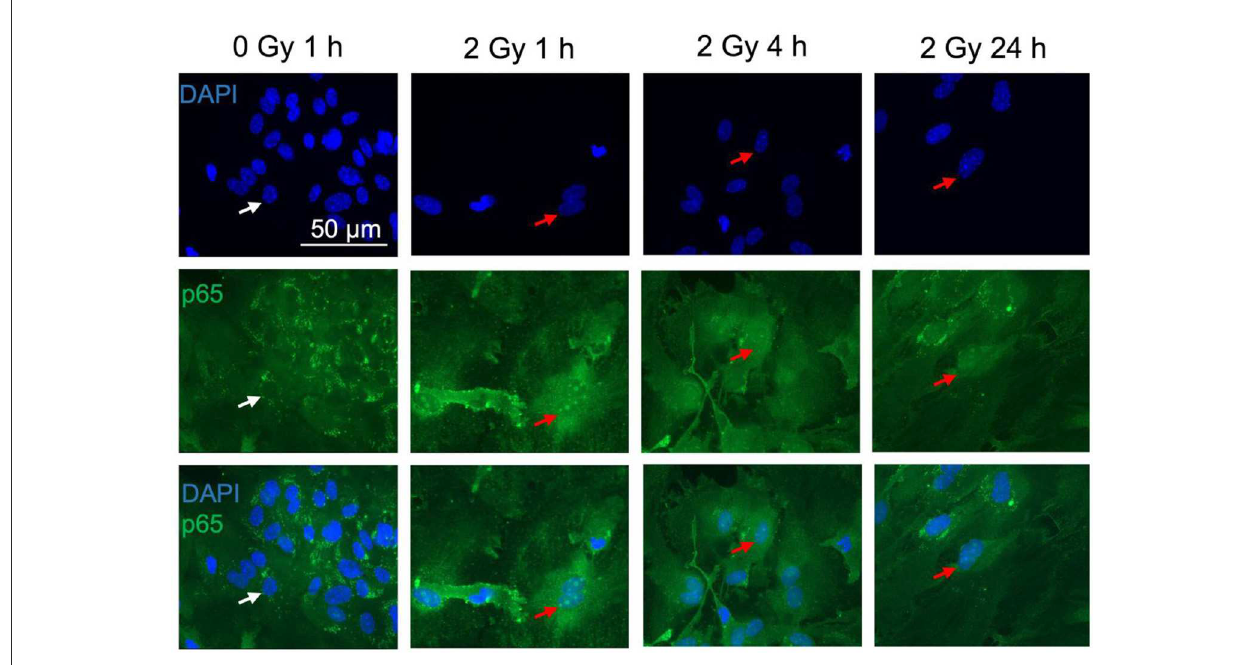
FIGURE8 The NF- κ B subunit p65 is detected in astrocytes. Astrocytes were exposed to 0Gy (mock-irradiated control) or 2Gy C ions (7 MeV/n, LET 220 keV/ µ m) and fixed 1, 4, and 24h after treatment for immunofluorescence staining of the NF- κ B subunit p65 (green). p65 is known to translocate from the cytoplasm into the nucleus upon NF- κ B pathway activation. For visualization of the nuclear translocation, nuclear staining with DAPI (blue) is displayed in the upper panel, p65 immunofluorescence in the middle panel, and merged pictures of DAPI and p65 are shown in the lower panel. White arrows mark cells without p65 translocation in the nucleus. Red arrows indicate cells with p65 nuclear translocation. Scale bar: 50 µ